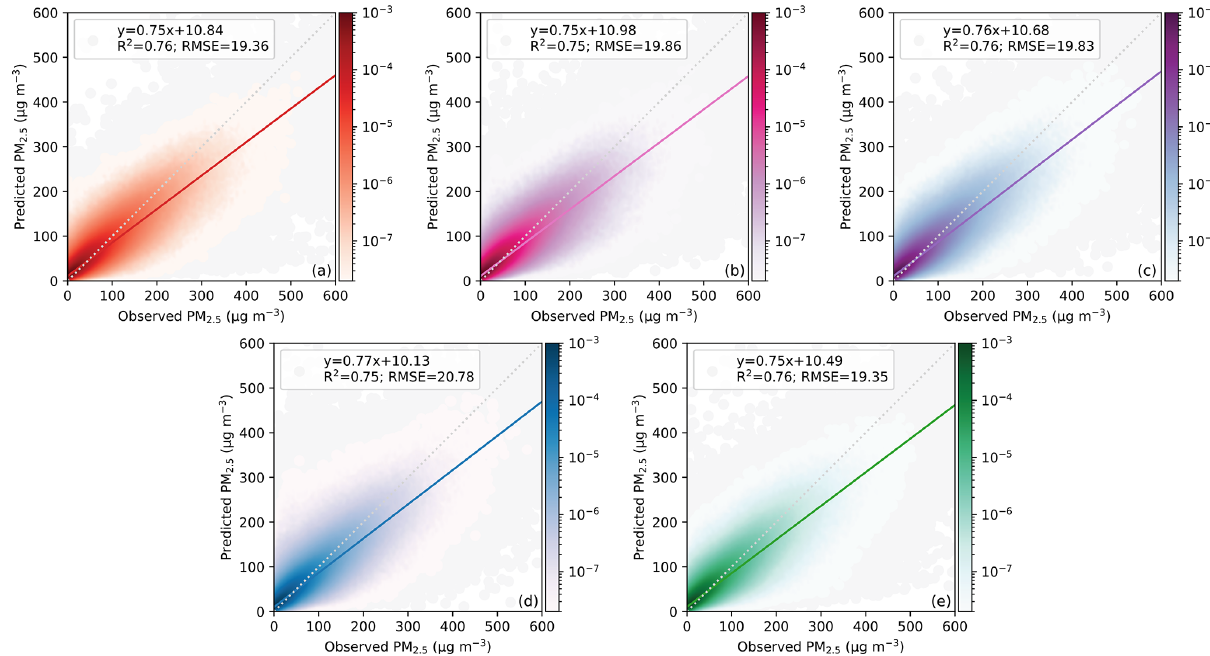
Figure 4. Density scatterplots of observed PM 2 . 5 and estimated PM 2 . 5 for each group of spatial CV results.